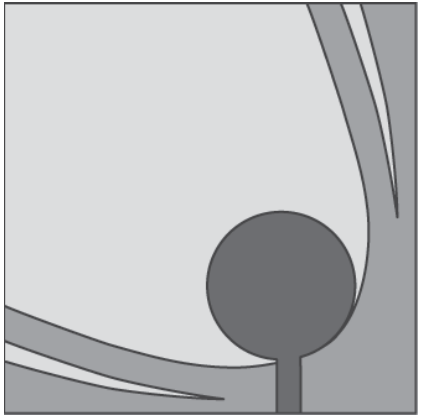
Figure 18. A modified parabolic-shaped ground plane-based directional circular antenna (redrawn from [77]). Dark gray top metal face, medium gray bottom metal face, and light gray dielectric